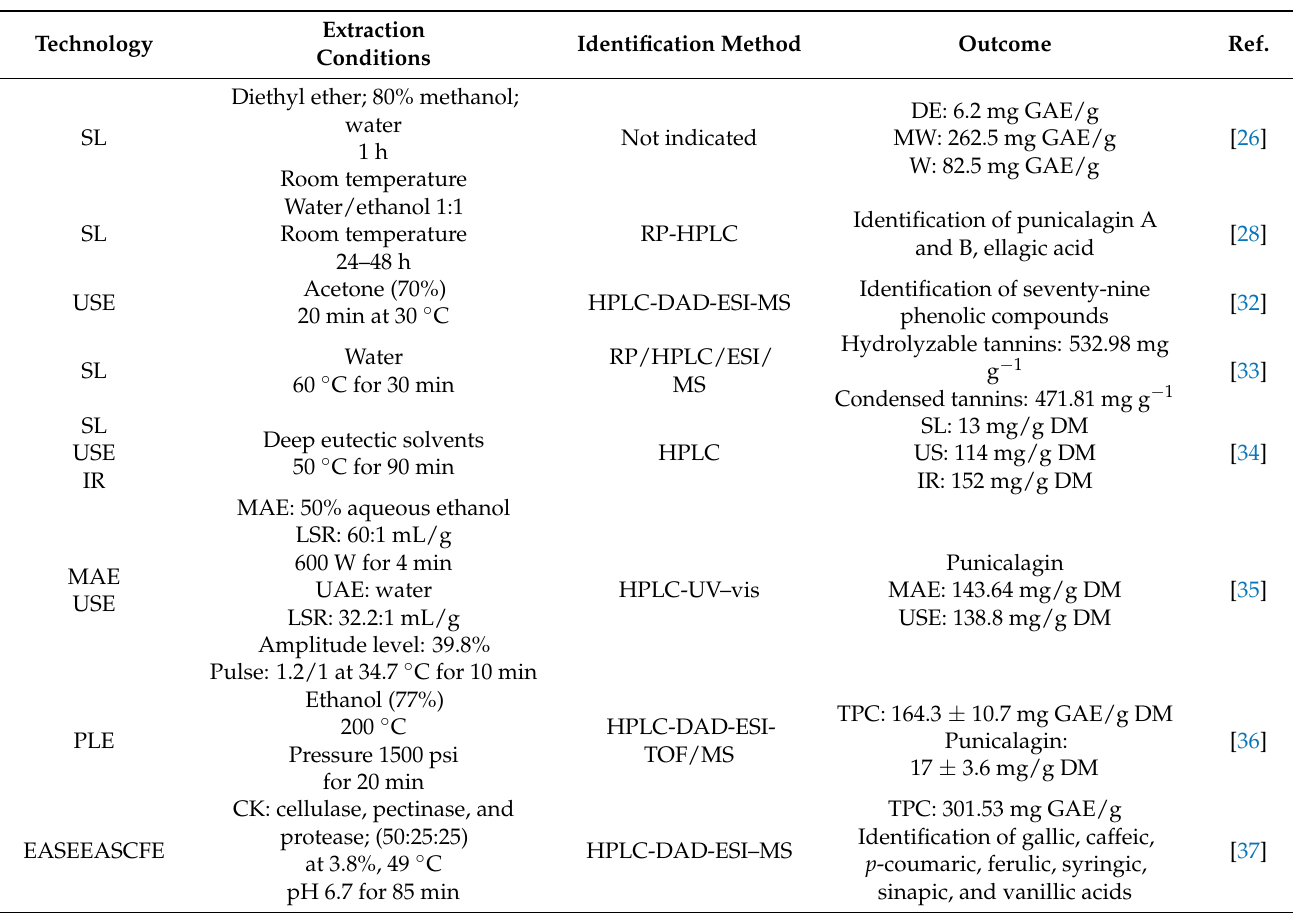
Table 1. Extraction technologies and analytical techniques used to obtain and characterize polyphenol compounds from pomegranate